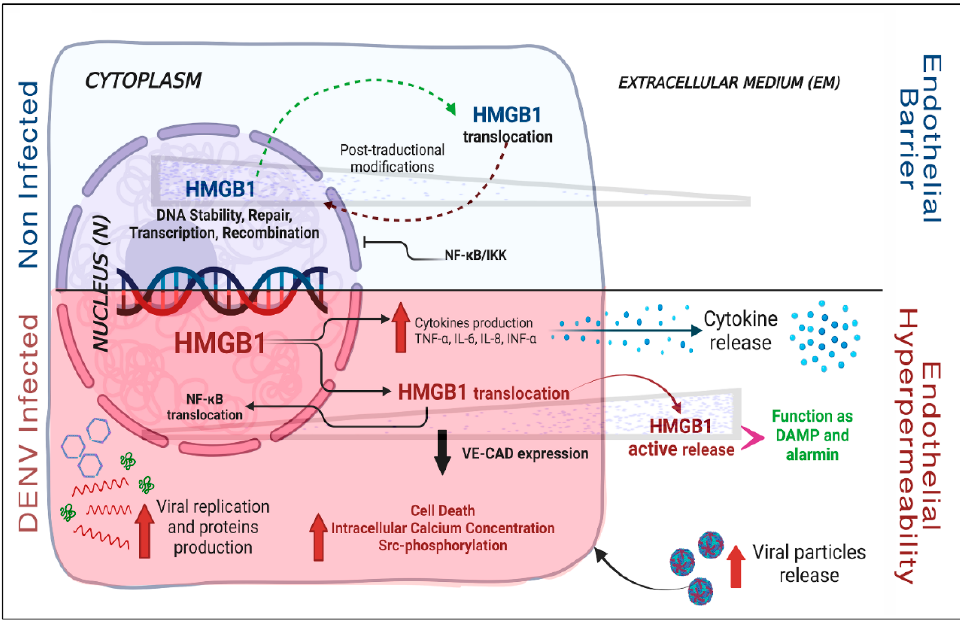
Figure 3. Evidence of HMGB1 protein localization and function in ECs during DENV infection. Without infection stimuli (blue), HMGB1 is mainly confined to the nucleus (N). In this condition, the gene transcription factor NF-kB remains in the cytoplasm inhibited by IKK. These mechanisms and others guarantee the endothelial barrier function.